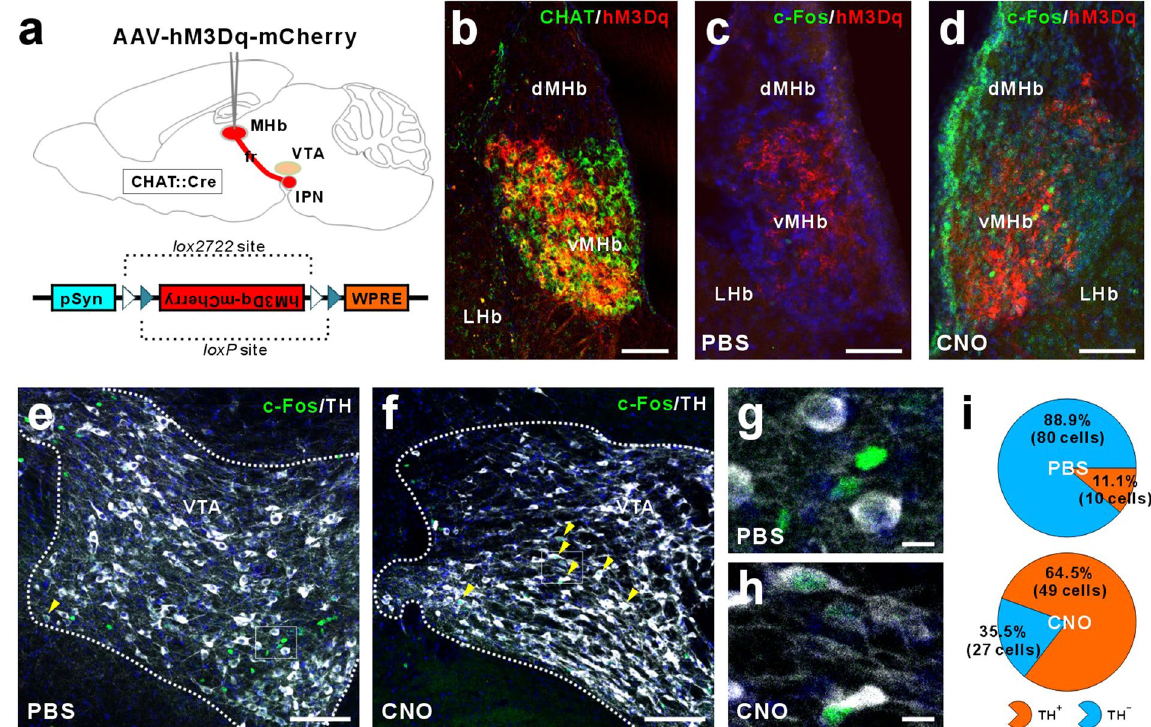
Figure 4. In vivo activation of MHb cholinergic neurons induces the excitation of dopamine neurons in the ventral tegmental area. ( a ) Pharmacogenetic stimulation by DREADD mice. We injected ChAT::cre mice with Cre-dependent hM3Dq virus (AAV-hM3Dq-mCherry) after 1 week habituation. ( b ) The mCherry- fused hM3Dq protein was expressed in the CHAT-positive habenula cholinergic neurons. ( c and d ) c-Fos expression (green) was induced in habenula cholinergic neurons expressing hM3Dq-mCherry (red) following pharmacogenetic selective stimulation for 60 min using i.p. injection of CNO. ( e – h ) CNO administration induced the increase of c-Fos immunoreactivity (green) in the TH-positive cells (i.e. dopamine neurons; white) and the decrease of c-Fos immunoreactivity in the TH-negative cells. Yellow arrow heads indicate the TH- positive and c-Fos-positive cells. ( i ) In CNO-injected DREADD mice, 64.5% of the dopamine neurons (n = 49 cells from 2 mice) and 35.5% of non-dopamine cells were c-Fos-positive. In contrast, saline-injected DREADD mice, 11.1% of the dopamine neurons (n = 10 cells from 2 mice) and 88.9% of non-dopamine cells were c-Fos- positive. Scale bar, ( b – f) 100 μ m; ( g and h) , 10 μ